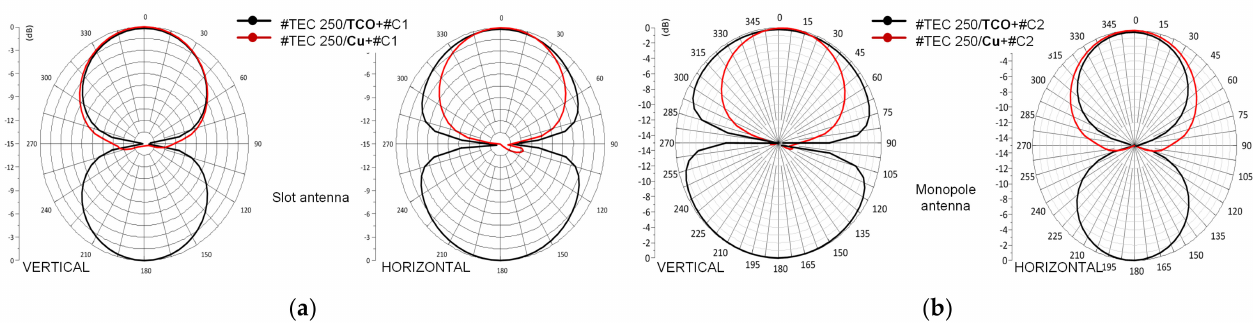
Figure 25. Vertical and horizontal directional diagrams (f 0 = 866 MHz): ( a ) Slot antenna #C1; ( b ) Monopole antenna